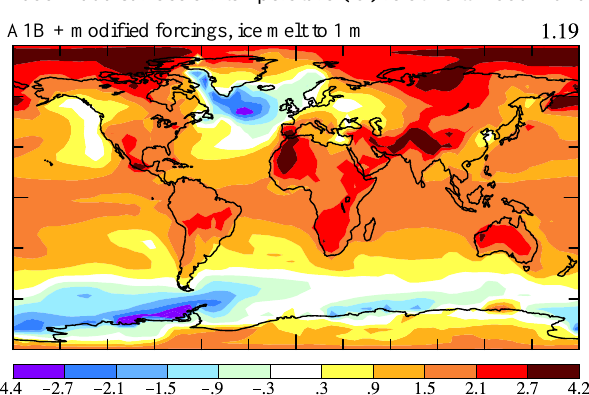
Figure 16. Surface air temperature ( ◦ C) change relative to 1880– 1920 in 2055–2060 for modified